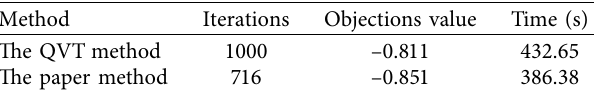
Figure 11: Convergence history of the compliant mechanism example: (a) the QVT method and (b) the paper method. Table 1: The data obtained from the compliant mechanism